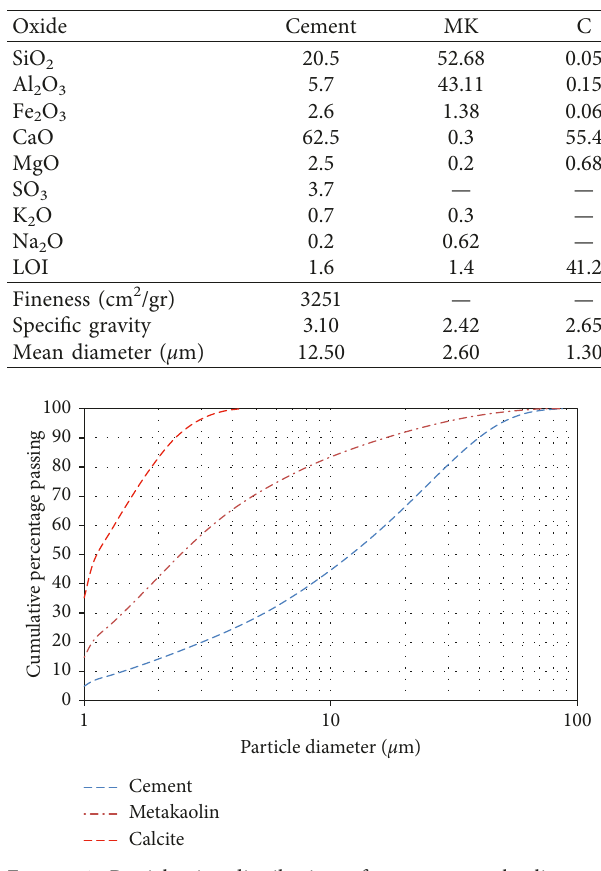
Table 1: Chemical composition and physical data for cement, MK, and C.